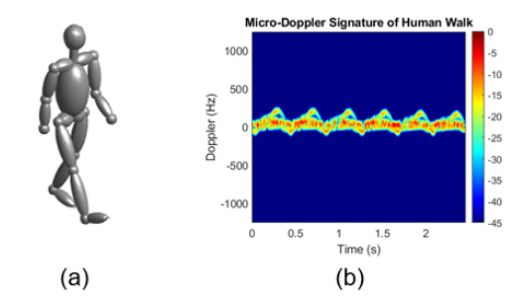
Figure 11. ( a ) human walking model, ( b ) micro-Doppler spectrogram of the simulated motion.